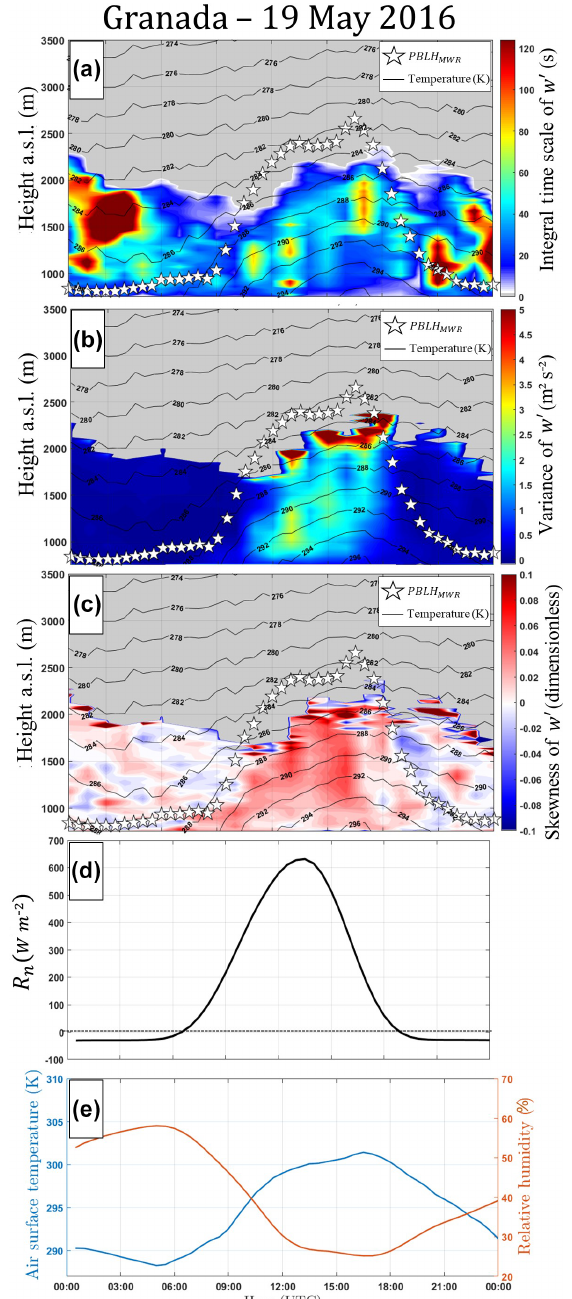
Figure 10. (a) Integral timescale obtained from Doppler lidar data ( τ w (cid:48) ), (b) variance obtained from Doppler lidar data ( σ 2 ness obtained from Doppler lidar data ( S w (cid:48) ), (d) net radiation ob- tained from pyranometer data ( R n ), and (e) air surface temperature (blue line) and surface relative humidity (RH – orange line) were both obtained from surface sensors. All profiles were acquired on 19 May 2016 in Granada. In (a) , (b) and (c) , black lines and white stars represent air temperature and PBLH MWR , respectively.